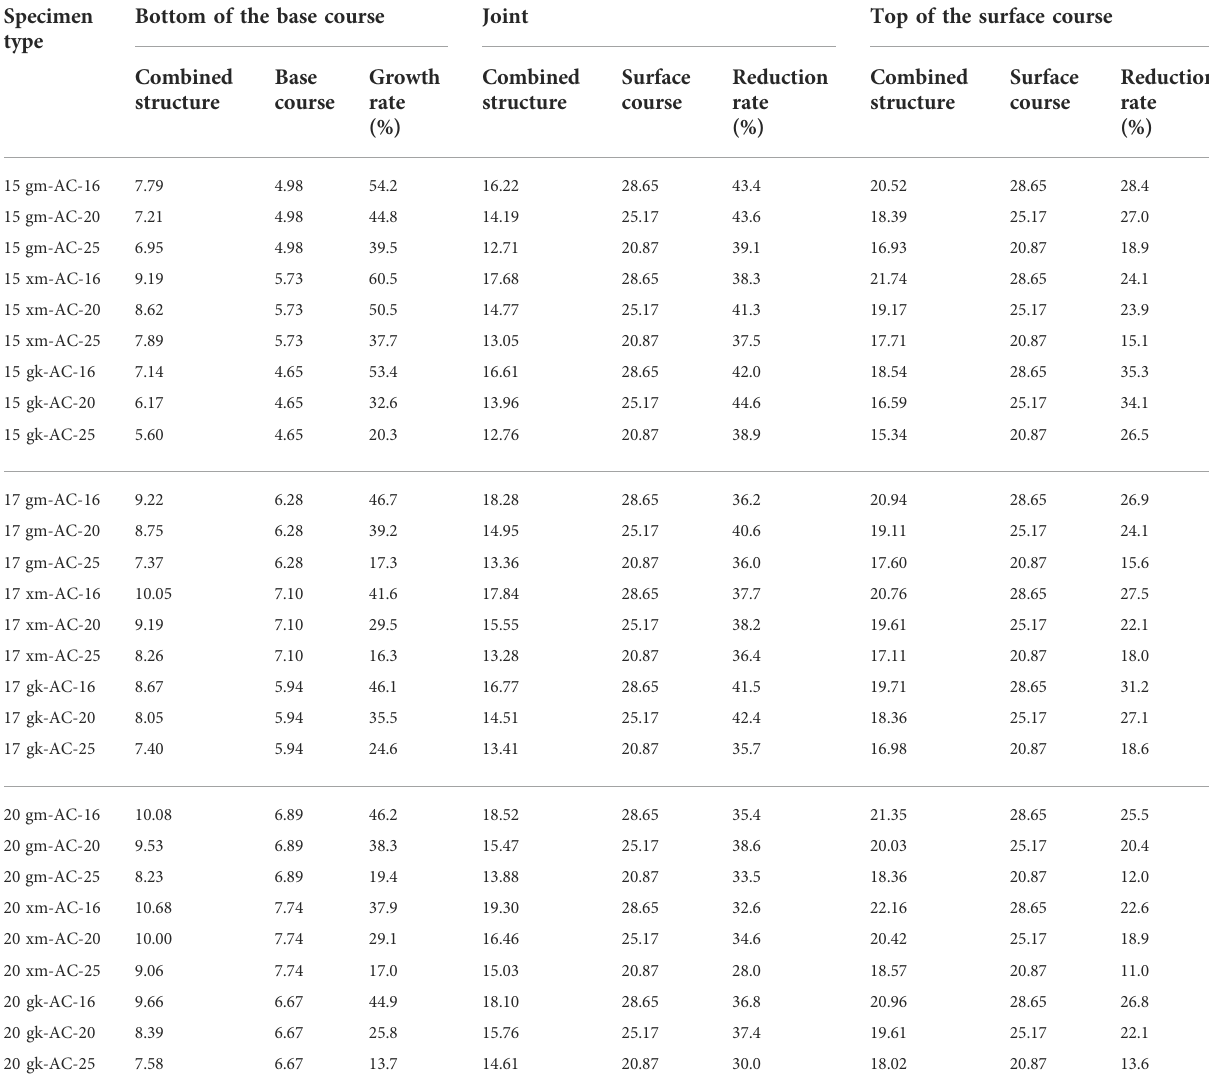
Specimen Bottom of the base course Joint Top of the surface course type Combined